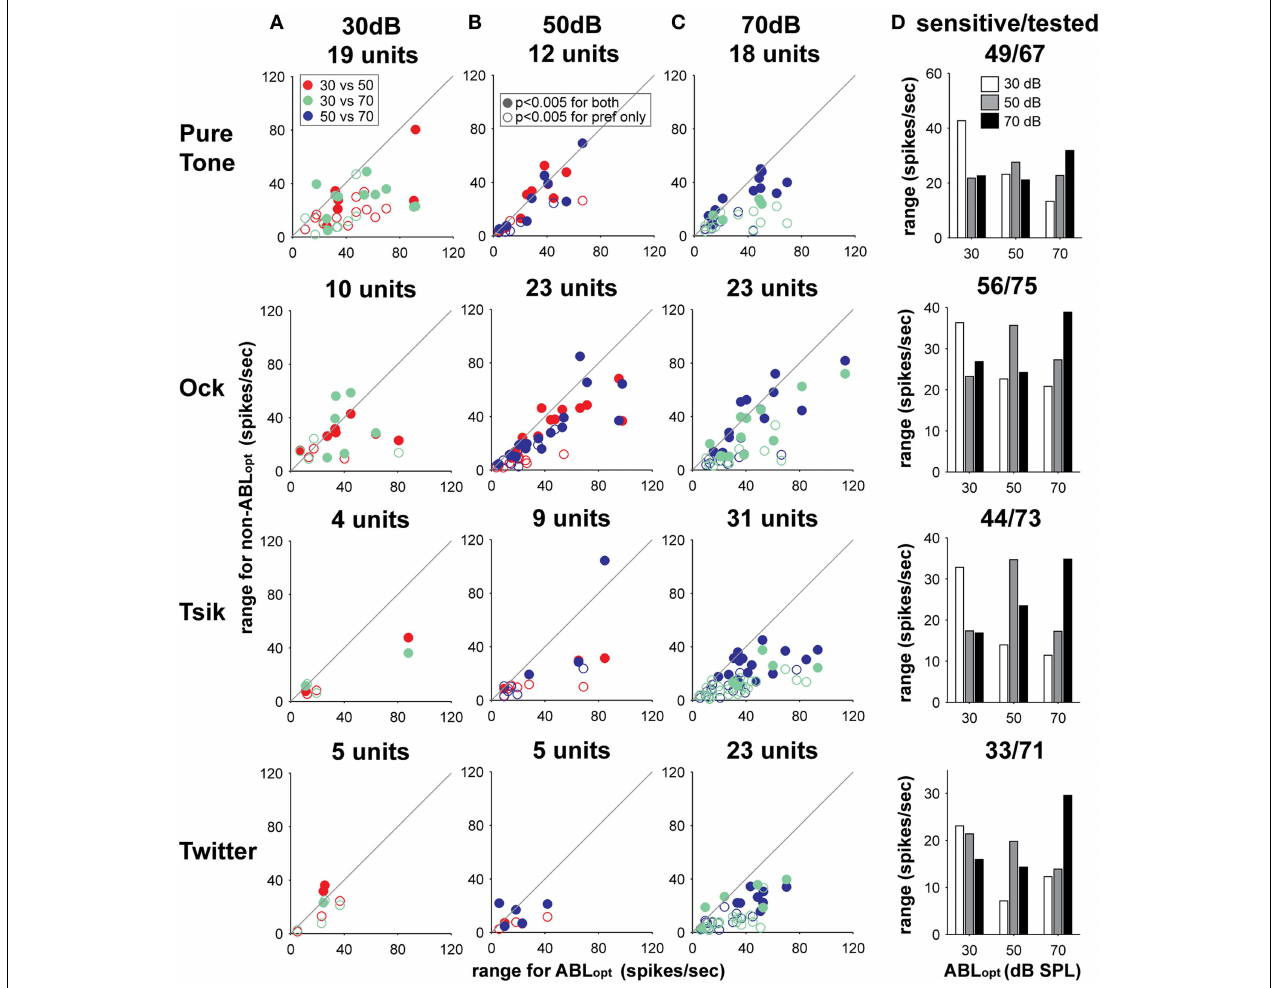
FIGURE 10 | Change in modulation range with respect to change in ABL. Each sub-plot in columns (A–C) illustrates the difference in modulation range between responses to the ABL opt in comparison to non-optimal intensities. Plots in columns (A–C) illustrate cells with different optimal intensities. Data from different call types or pure tones are shown on different rows; the identity of the stimulus is indicated on the left. The number of cells with a particular ABL opt for a particular stimulus type is shown above each